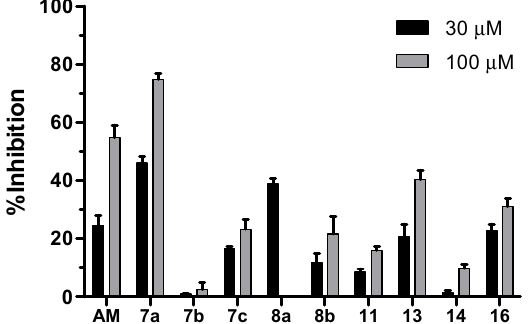
Figure 3. Inhibitory effect of compounds 7a – c , 8a – b , 11 , 13 , 14 , 16 on N -Methyl D -Aspartate (NMDA)-induced intracellular calcium increase in cultured cerebellar granule neurons are shown at 30 µ M (black) and 100 µ M (dark grey) of each compound. Amantadine (AM) at 30 µ M and 100 µ M was included in the assay as a positive control. Compound 8a was not evaluated at 100 µ M due to solubility issues.